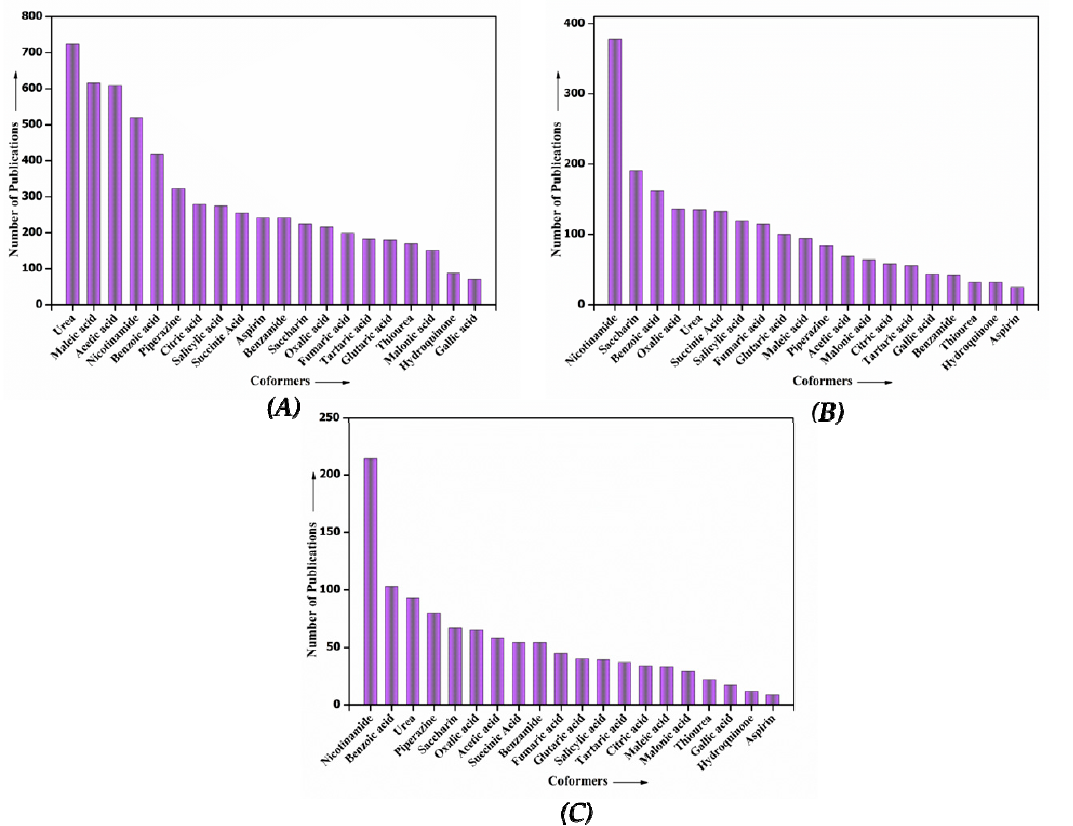
Figure 11. Graphical representation of coformers in high demand in the last 20 years by ( A ) Sci- enceDirect ( B ) Web of Science, and ( C )